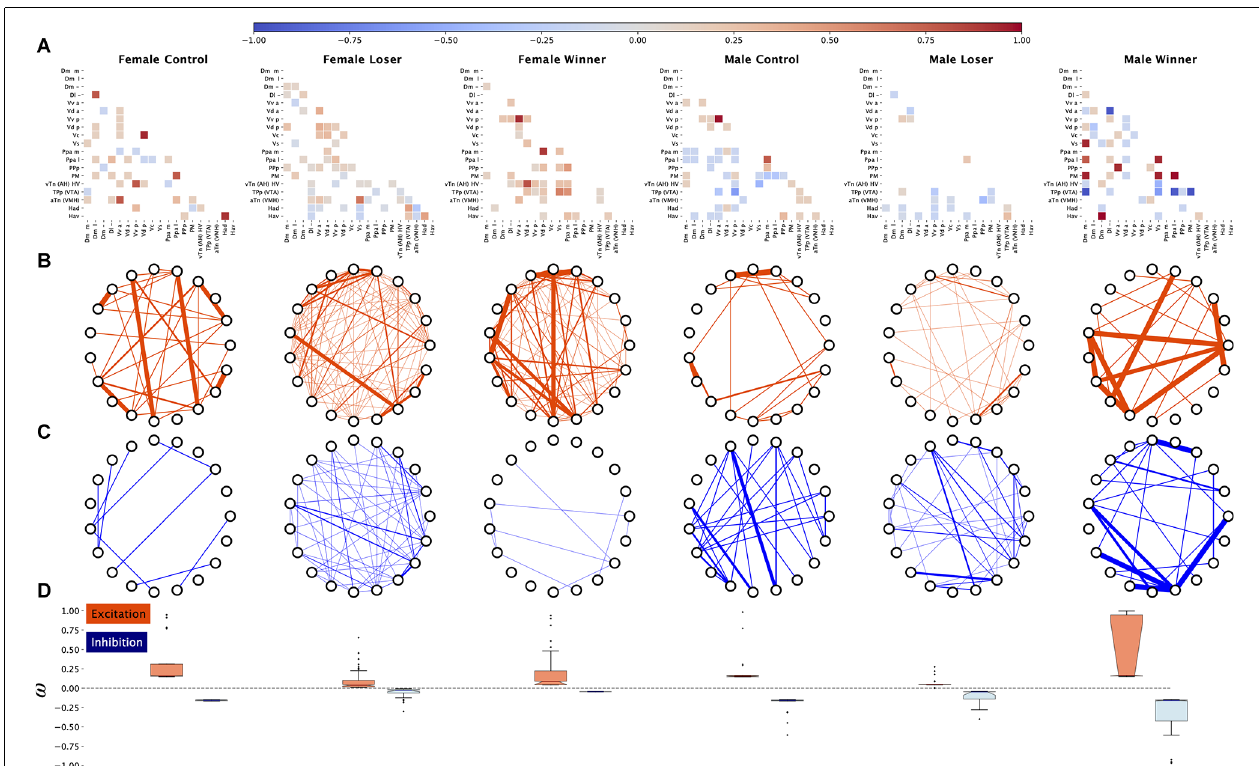
FIGURE 4 | Functional connectivity across the brain regions induced by aggressive interactions, inferred from pS6 immunoreactive cells used as a marker of neural activity. (A) Adjacency matrices for each treatment showing the strongest negative and positive edges, sparsified for visualization puroposes, (B) excitation (positive weights) subnetworks for each treatment, (C) inhibition (negative weights) subnetworks for each treatment, (D) distributions of edge weights for excitation and inhibition subnetworks for each